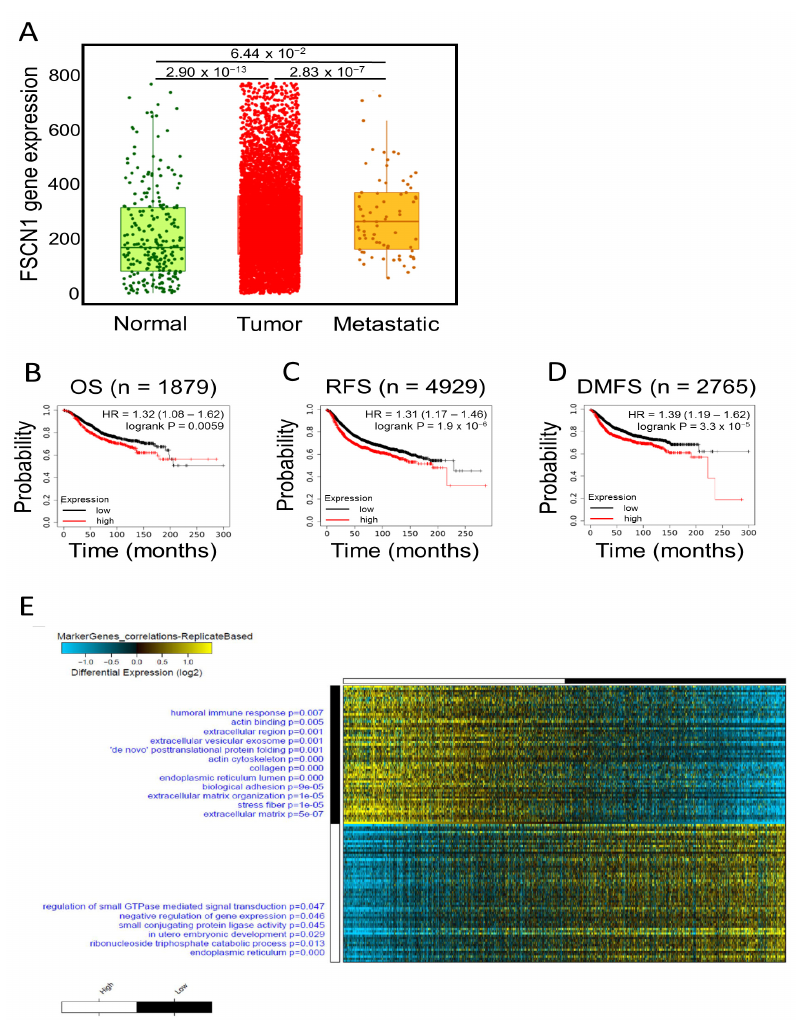
Figure 1. Expression, survival and differential gene expression in FSCN1 high compared to FSCN1 low breast cancer patients from TCGA dataset. ( A ) Boxplot showing fascin expression in normal ( n = 242), tumor ( n = 7569) and metastatic ( n = 82) breast cancer patients. Kaplan-Meier plots showing ( B ) overall survival (OS; n = 1879), ( C ) recurrence-free survival (RFS; n = 4929) and ( D ) distant metastasis-free survival (DMFS; n = 2765) as function of median FSCN1 expression in breast cancer patients. The significance between FSCN1 high and FSCN1 low groups was calculated using the log-rank test. p -values are indicated on each plot. ( E ) Marker discovery analysis to identify putative markers selectively expressed in FSCN1 high ( n = 534) vs. FSCN1 low ( n = 545) stratified according to median FSCN1 expression from TCGA BRCA dataset ( n = 1217). Enriched gene ontology (GO) associations are indicated on the y axis.